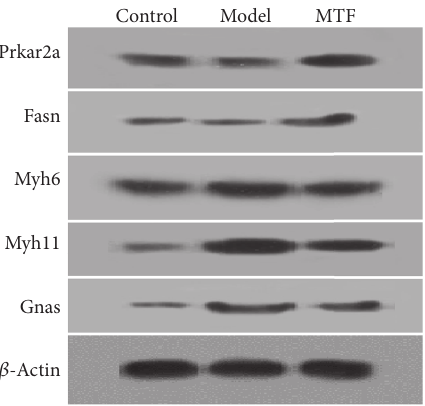
Figure 4: Western blots of the five DPs (Prkar2a, Fasn, Gnas, Myh11, and